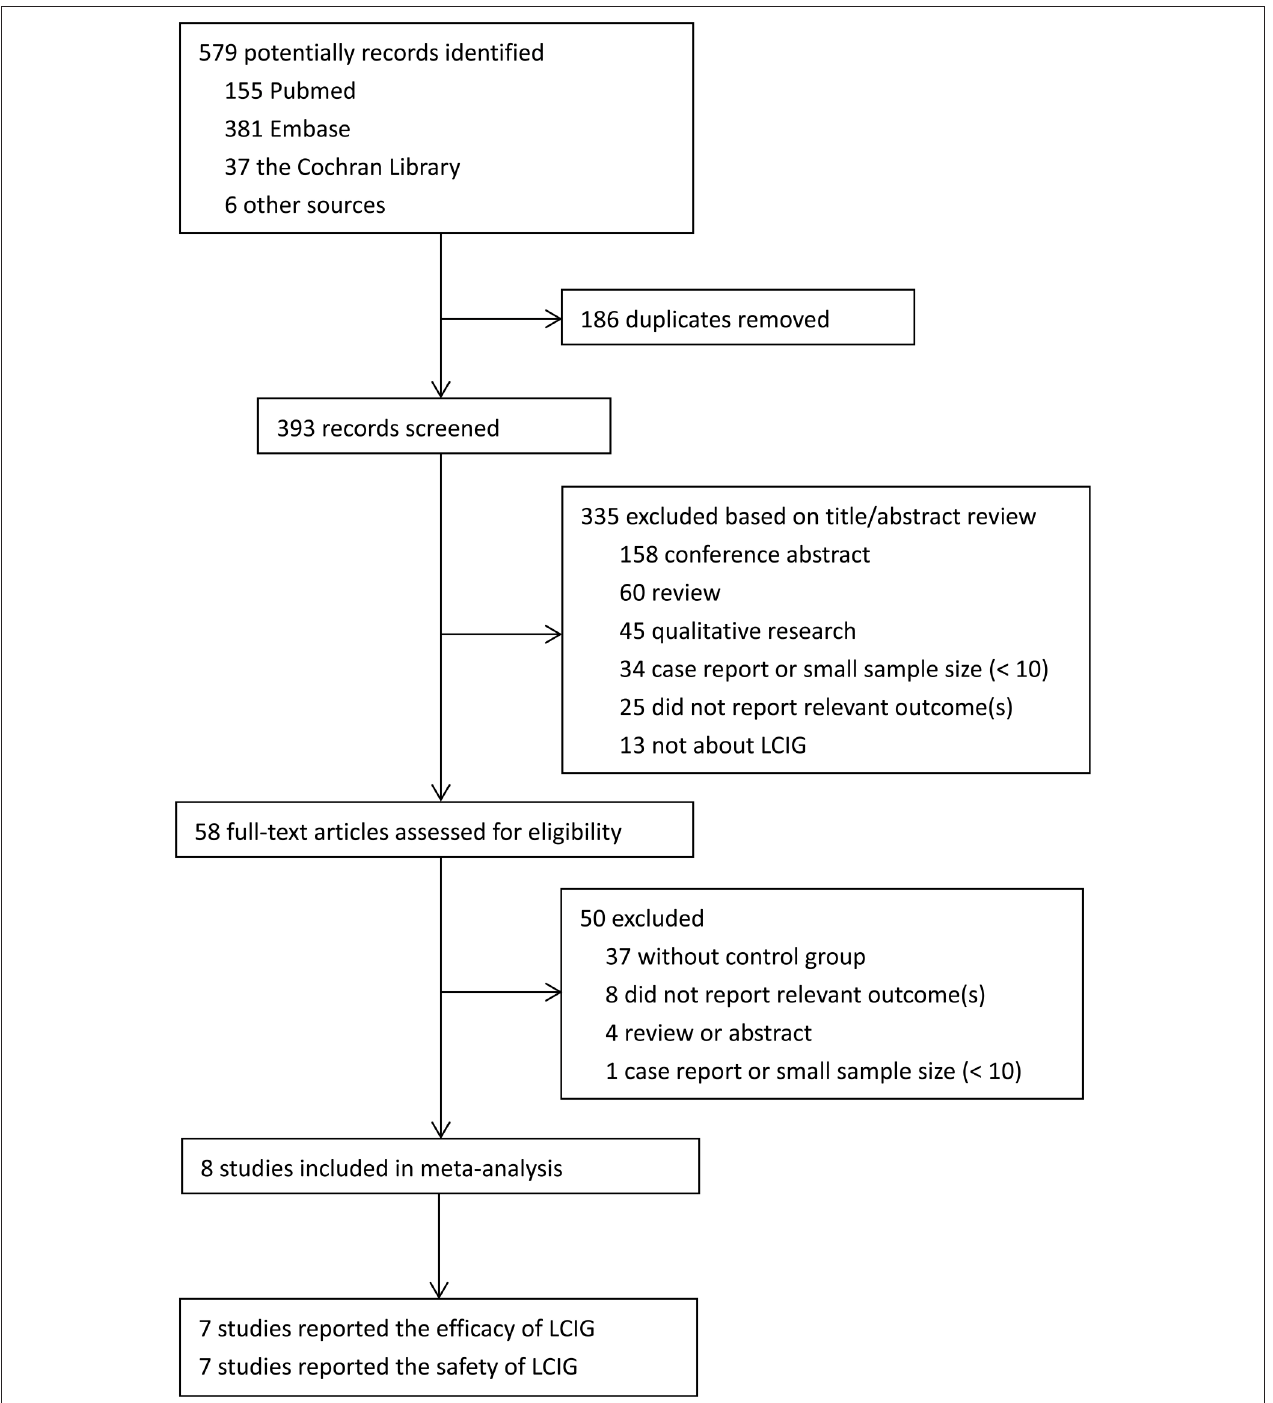
FIGURE 1 | PRISMA flow chart of Study Selection in Meta-analysis.